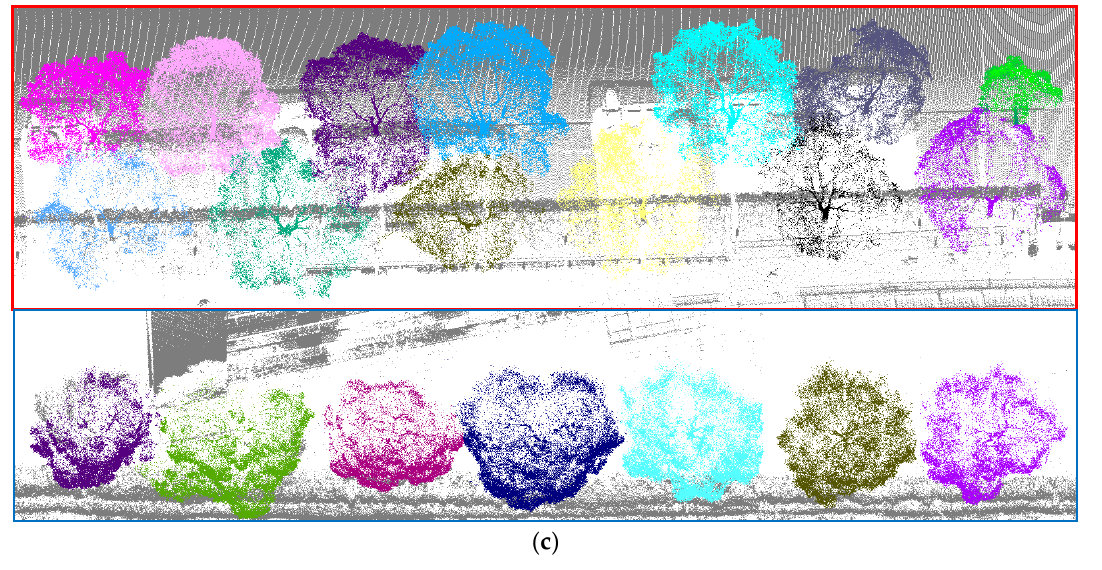
Figure 8. Example of individual tree segmentation on Dataset I. (a) Input tree point cloud, where green and gray points represent points from trees and non-tree objects, respectively, (b) individual tree segmentation result, dotted in different colors, (c) two close-up individual tree segmentation results at some selected regions.